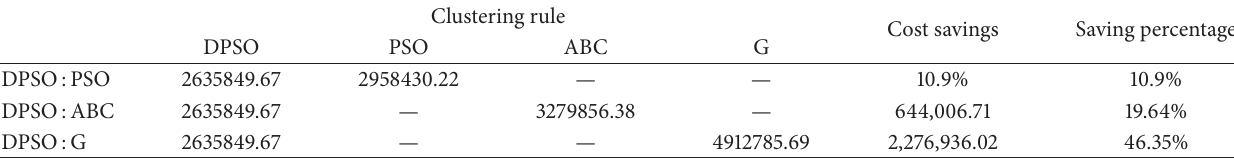
Table 2: Analysis of the difference in cost using the DPSO clustering method and other clustering